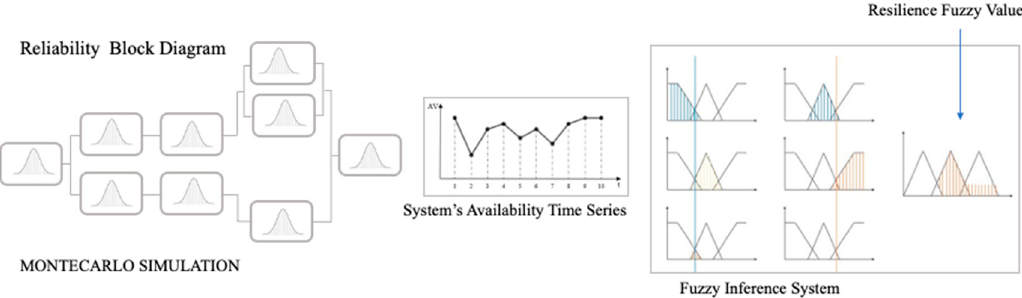
Figure 2. Flowsheet between RBD-based Monte Carlo simulation and Fuzzy Resilience Indicator.